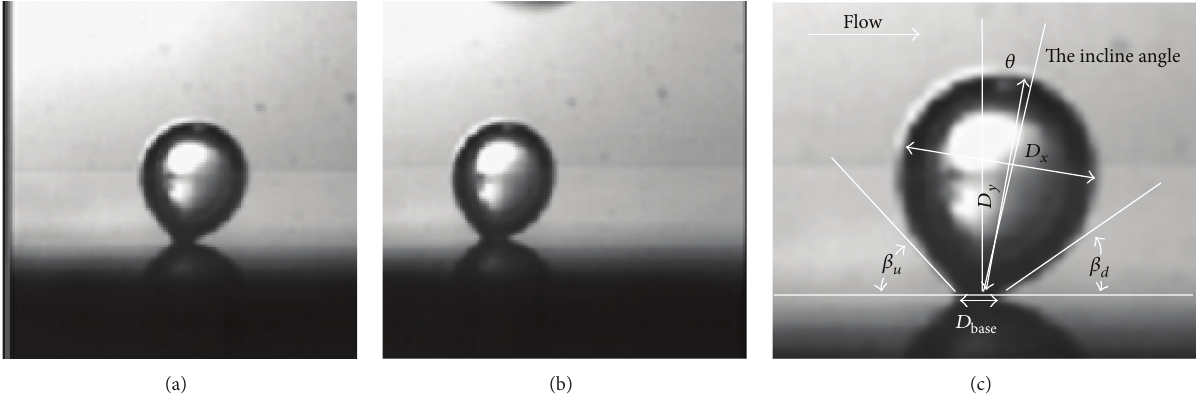
Figure 2: Dynamic contact angle at bubble base during flow boiling [23].